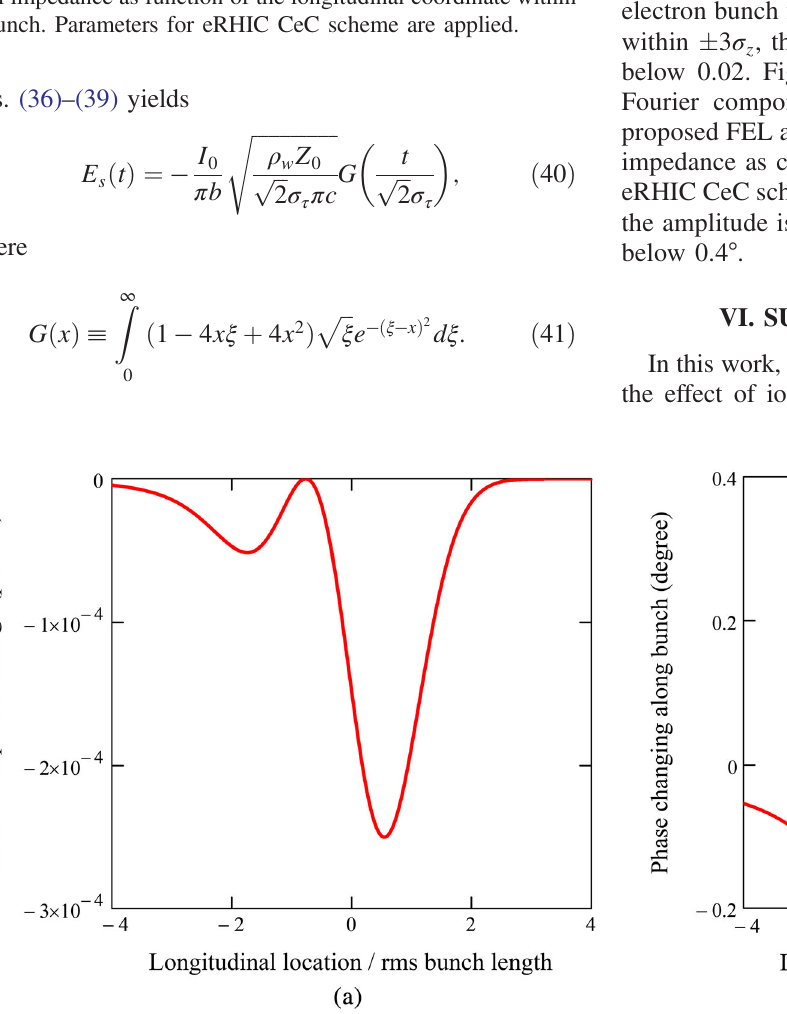
FIG. 13. Influences of the resistive wall wake field on the Fourier component of the longitudinal density modulation at the FEL ¼ 423 nm. The ion is at rest, and the parameters from eRHIC CeC scheme are applied. The abscissa is the resonant wavelength, λ FEL longitudinal location in units of rms bunch length. (a) The relative change in percentage of the amplitude of the Fourier component calculated from Eq. (28); (b) the phase change of Fourier component in degrees, calculated from Eq.